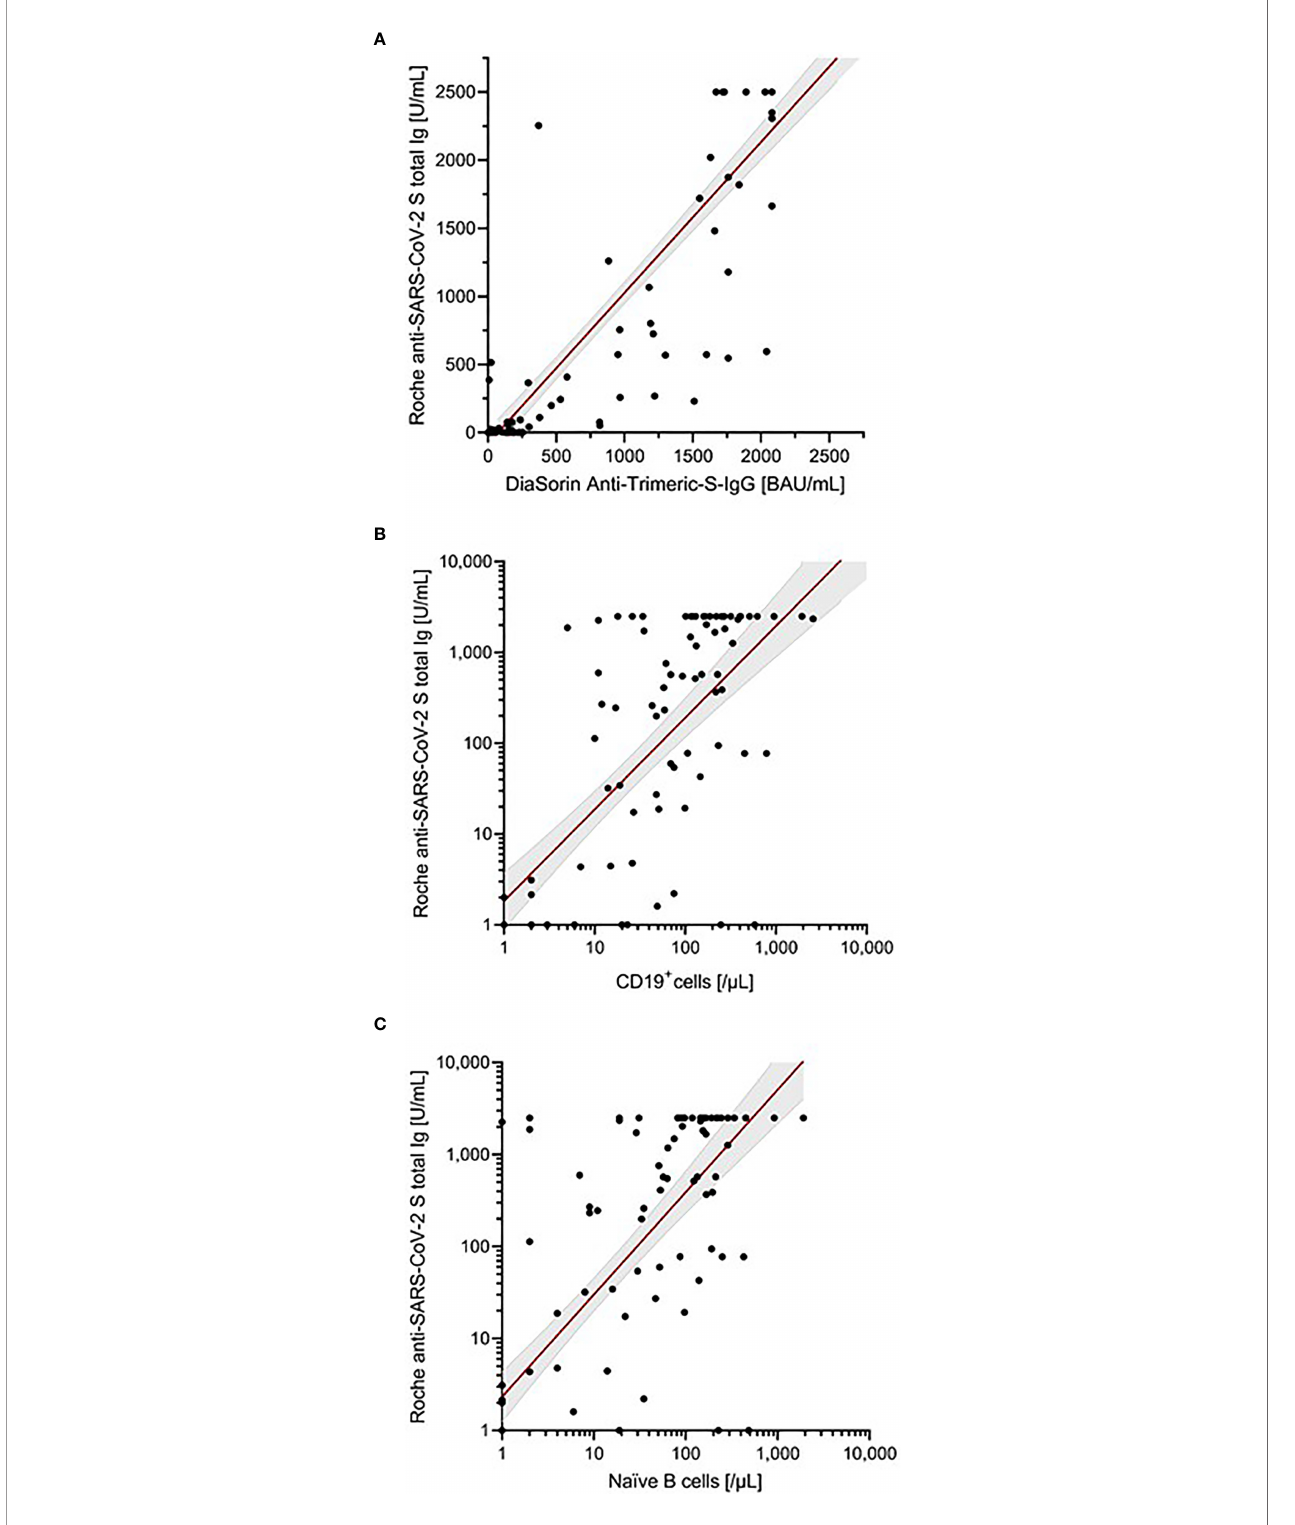
FIGURE 2 | Correlation of antibody levels determined by Roche anti-SARS-CoV-2 S assay. (A) DiaSorin SARS-CoV-2 TrimericS IgG. (B) Absolute number of B cells (CD19 + cells). (C) Absolute number of naïve B cells. Scatter plots indicate a linear regression line including a 95% con fi dence interval. In case of (B, C) , regression line corresponds to transformed data using x=log((x+1) and y=log((y+1)),